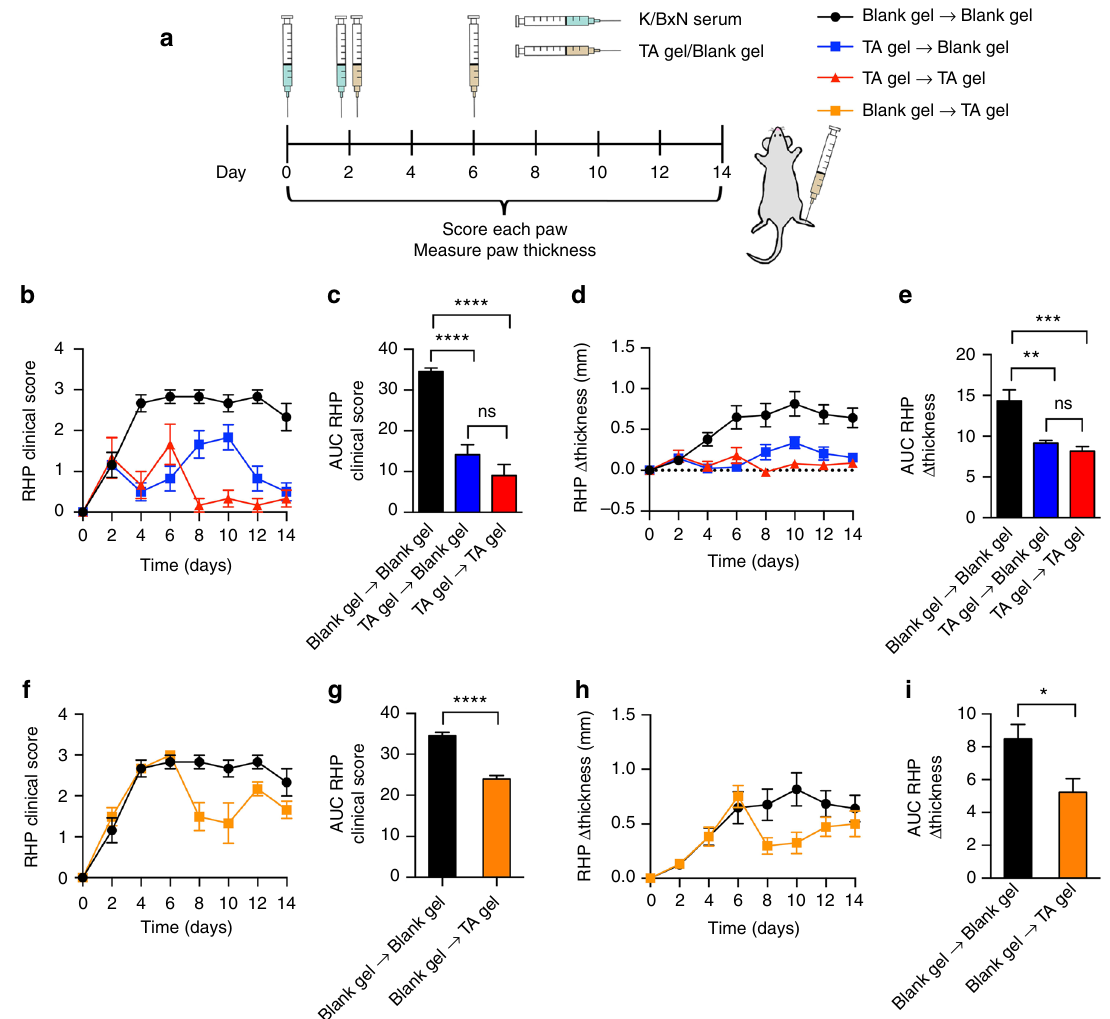
Fig. 6 Local delivery of TA-loaded TG-18 hydrogel demonstrates therapeutic ef fi cacy in severe arthritis. a Experimental outline: Arthritis was induced by i.p.